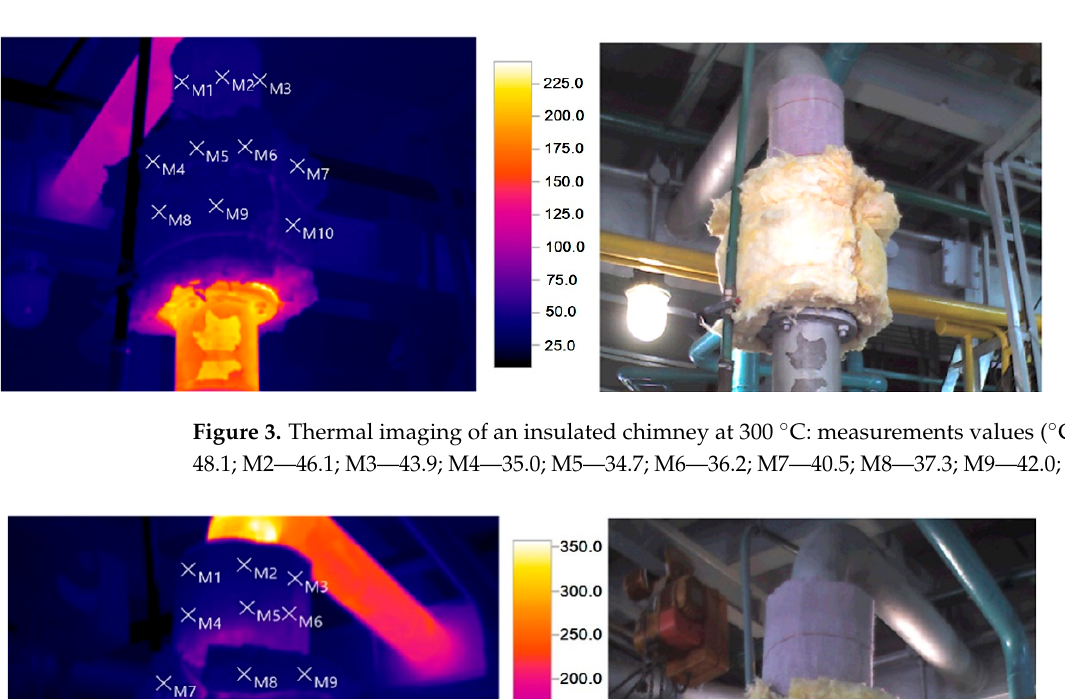
Figure 2. Thermal imaging of the chimney at 300 °C.